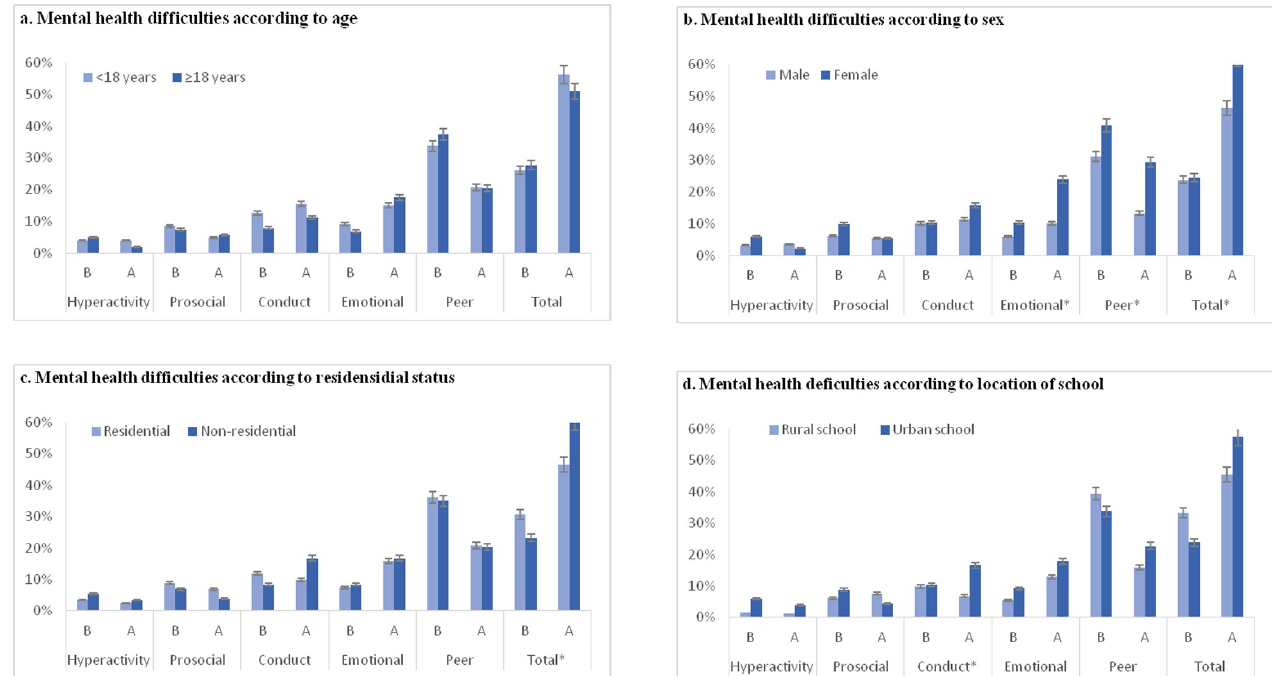
Fig 2. Stratification of mental health strengths and difficulties according to (a) age, (b) sex, (c) residential status and (d) location of the school. Footnote: � x 2 < 0.005. B implies borderline and A implies abnormal mental health status.